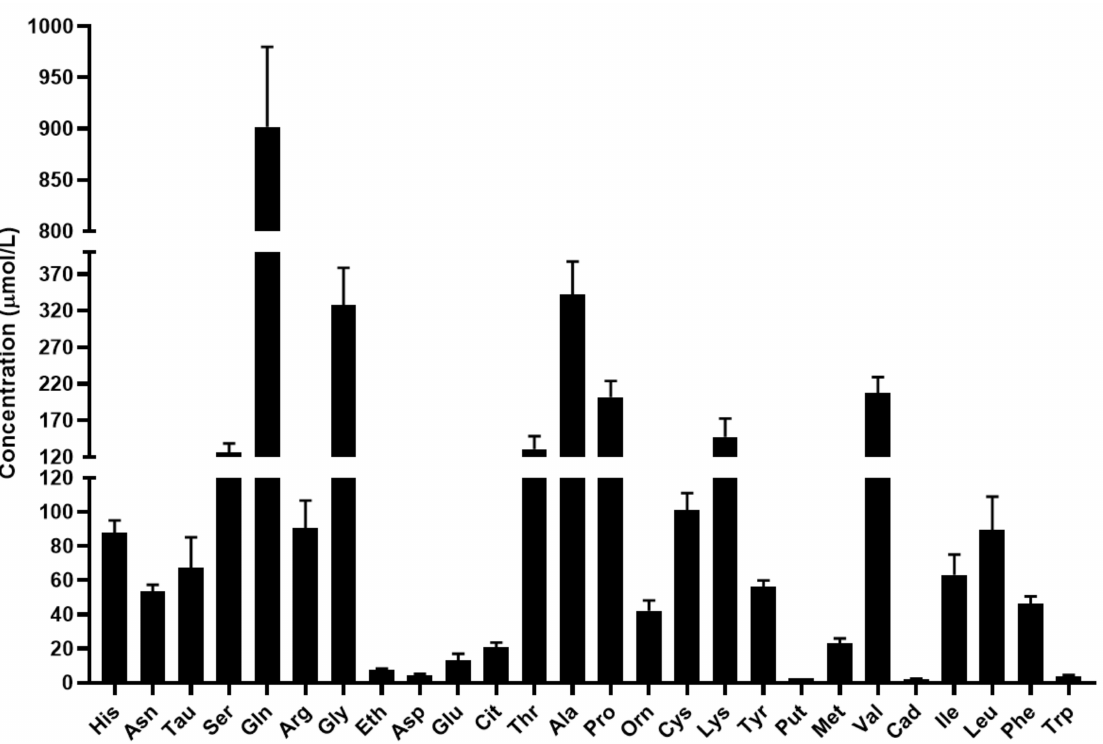
Figure 3. Concentration of the quantified amino acids and biogenic amines in serum in µ mol/L. For amino acids the three-letter code was used, Tau: taurine, Eth: ethanolamine, Put: putrescine, Cad: cadaverine, Tra: tyramine. Table 3. Concentration of amino acids and biogenic amines in tears. OS: Oculus sinister, OD: oculus dexter, <LOQ: the molecule was identified with UHPLC-UV analysis, but the concentration was lower than the limit of quantification, SRM: the molecule was detected by SRM, but the concentration was below the limit of quantification, N.D.: not detected. The data represent the mean value of two technical